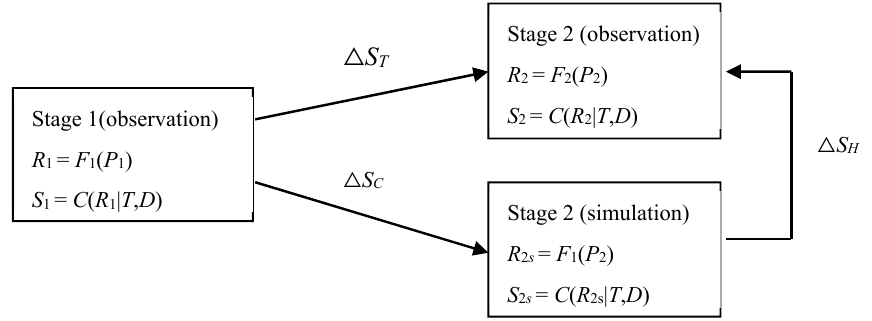
Figure 2. Schematic diagram of quantitative identification of drought risk attribution.